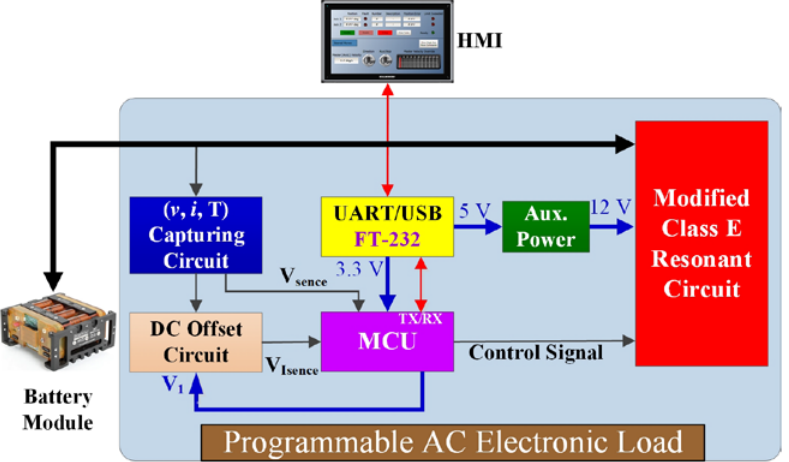
Figure 1. Circuit architecture of the proposed high-frequency alternating current (AC) electronic load for lithium battery module. Legend: HMI, human–machine interface; MCU,